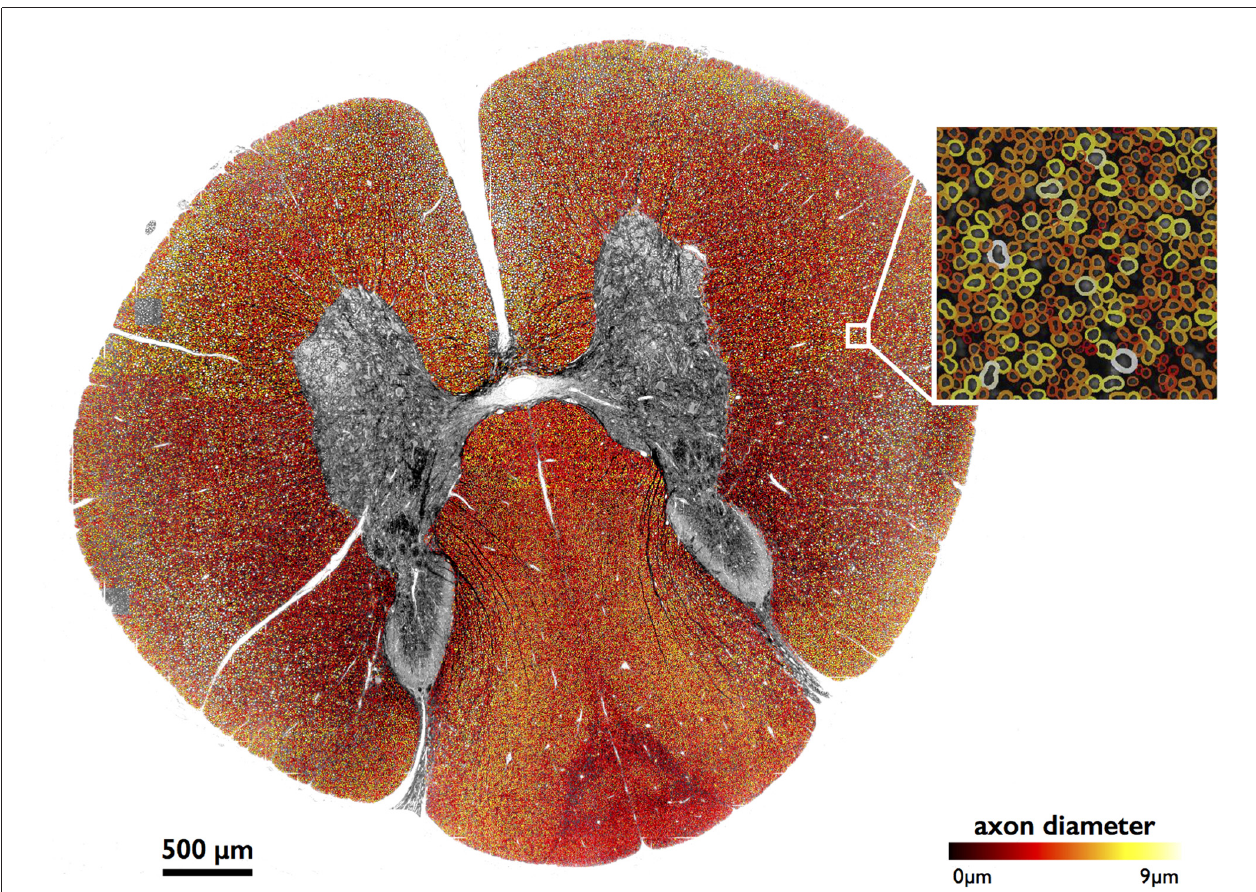
FIGURE 4 | Large-scale segmentation (axon display) in a cat spinal cord (cervical section), color-coded for axon diameter. Myelin display (color-coded for axon diameter) is used in the zoomed region. Note that the regions outside of the white matter were masked out for better clarity, using automatic tools from